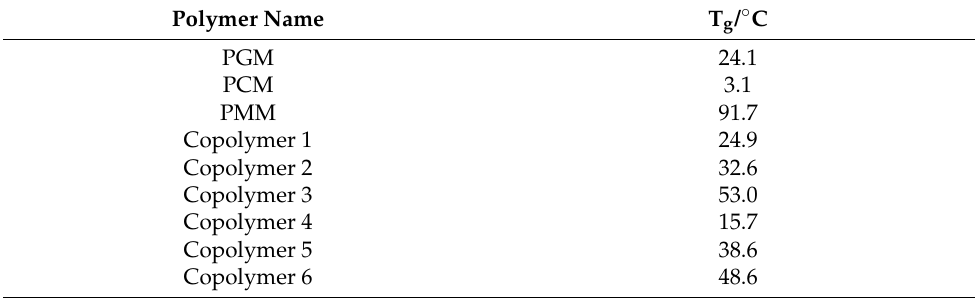
Figure 3. DSC curves for the obtained polymeric materials. Table 8. Glass transition temperatures (T g ) for the obtained polymeric materials.